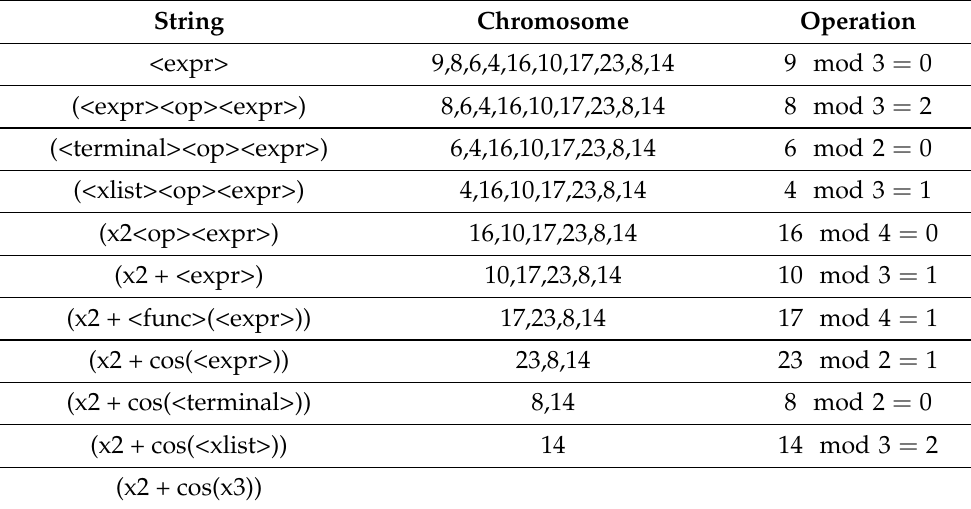
Table 1. Steps to produce a valid expression from the BNF